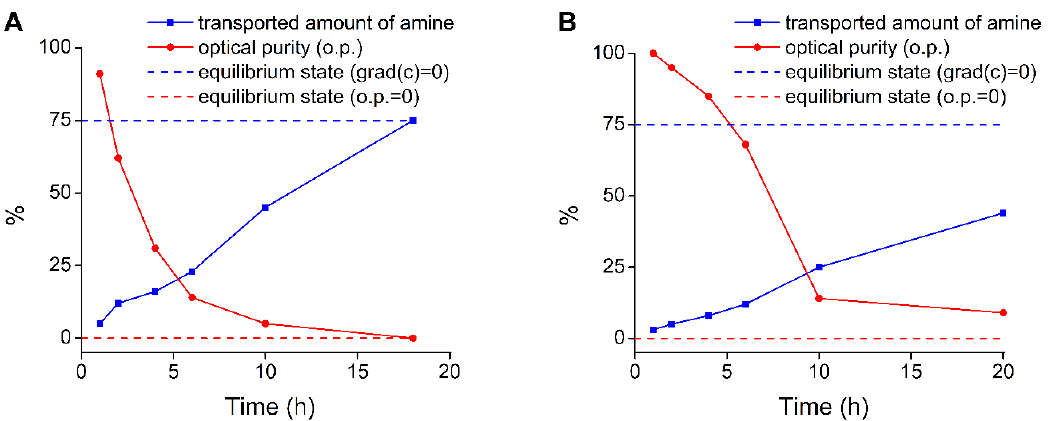
Figure 5. Time dependence diagrams for the transport of racemic NEA ( 21 ) ( A ) and racemic PEA ( 22 ) ( B ) using crown ether ( R , R )- 2 as a carrier.